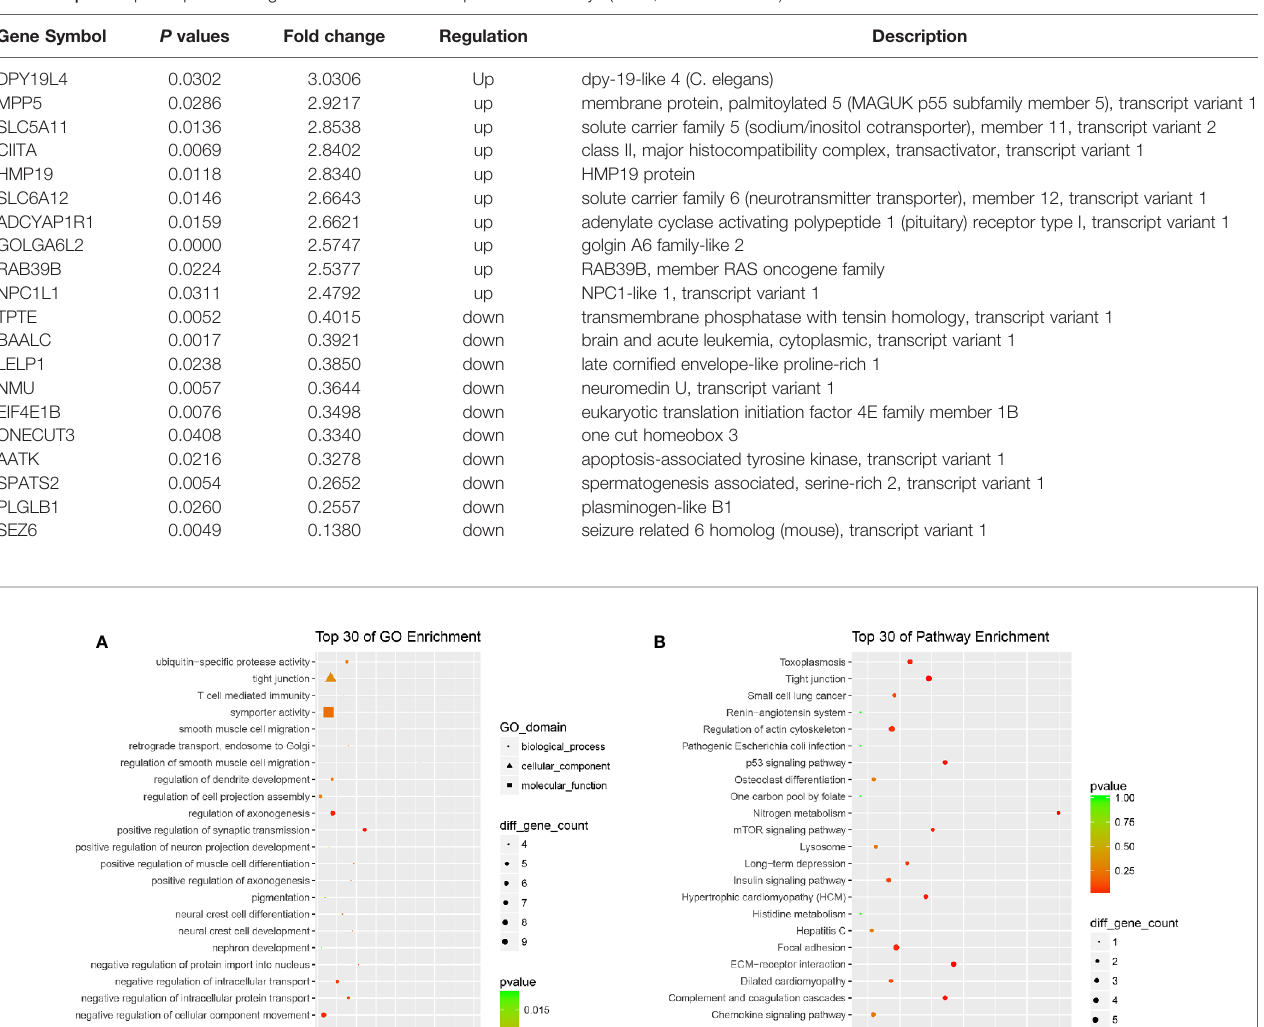
TABLE 2 | The top 10 up-/down-regulated mRNAs in transcriptome microarrays (n = 3, Que vs Ox-LDL). Gene Symbol P values Fold change